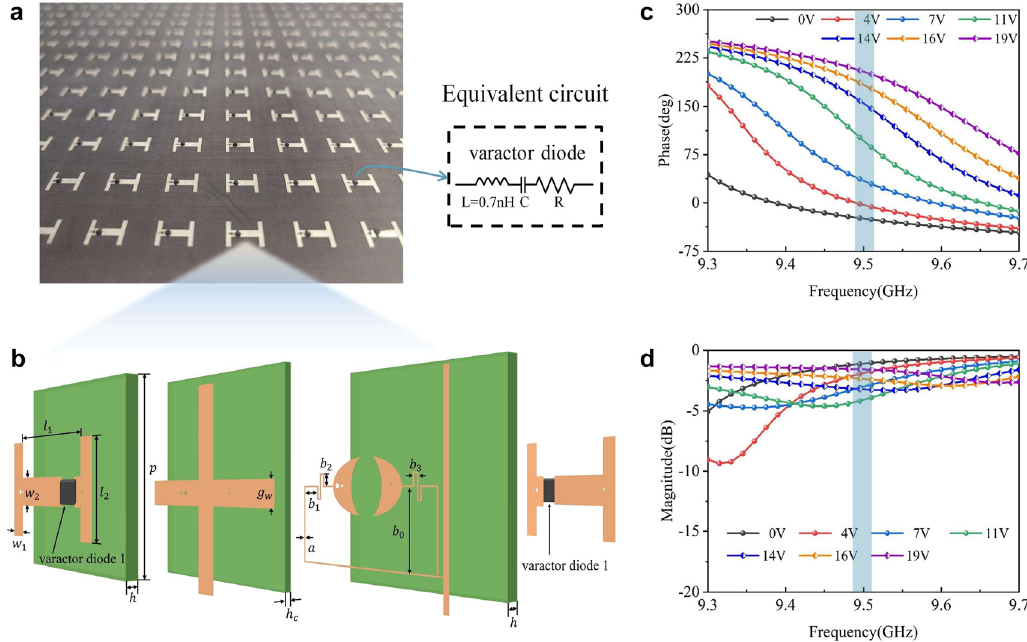
Figure 2: Design of the tunable transmissive metasurface. (a)Schematicoftheproposedtunabletransmissivemetasurface.(b)Structureofthemeta-atom.Incorporatingtwovaractordiodesallowsthe